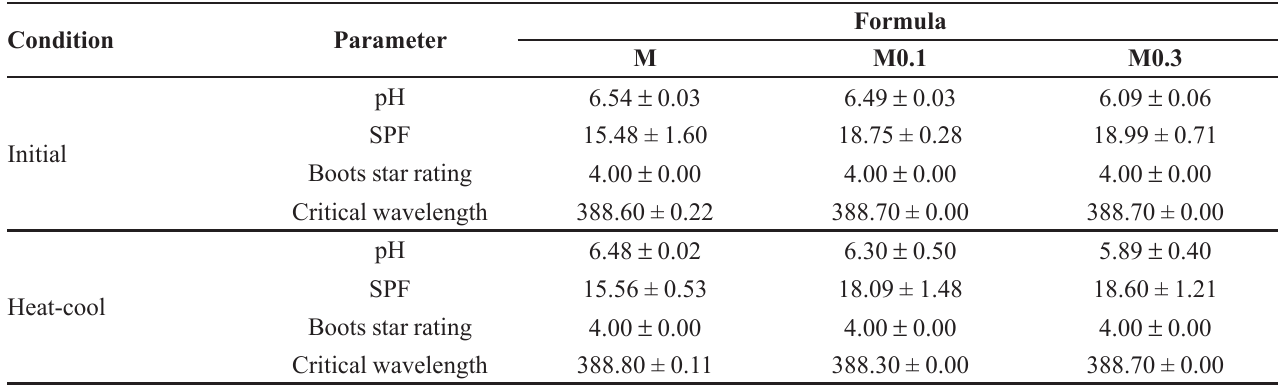
TABLE V - Stability of passion fruit concealer mousse Condition